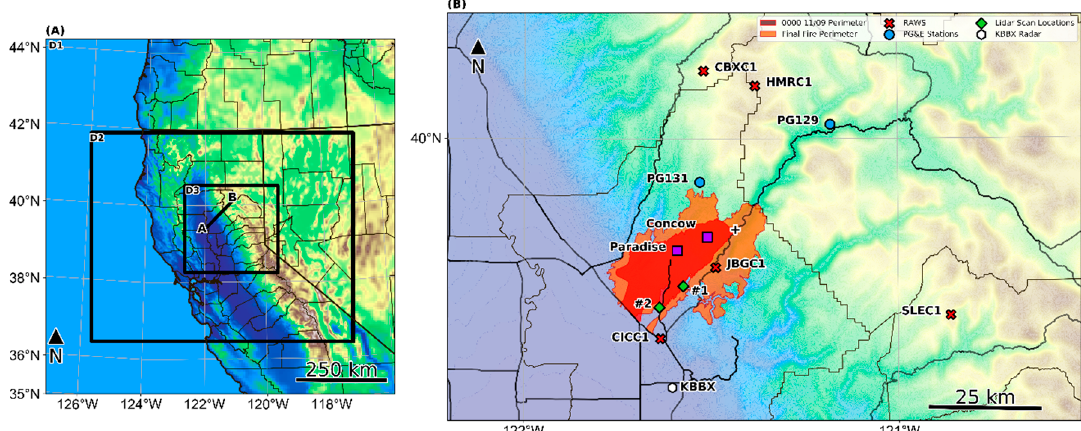
Figure 1. ( A ) Domains used in weather research and forecasting (WRF)-advanced research WRF (ARW) simulations and topography shaded. Outer domain D1 has a grid spacing of 6 km, with inner domains D2 and D3 grid spacing of 2 km and 0.666 km, respectively. Line AB represents the cross-section used in this analysis; ( B ) WRF model terrain (shaded) with locations of remote automated weather station (RAWS) (Xs), Pacific gas and electric (PG&E) stations (circles), lidar scan locations (diamonds), KBBX radar (hexagon), approximate ignition point (“ + ”), and city locations (squares). Shaded in red are Camp Fire perimeters with the inner perimeter from 00:00 PST 9 November 2018 and the outer perimeter being the final perimeter. Table 2. WRF model parameterization name and namelist option.